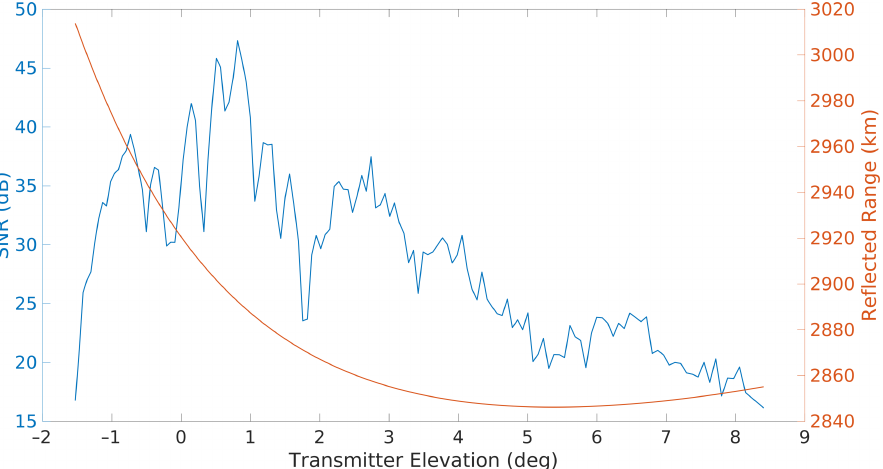
Figure 9. An example pass showing the detections of the International Space Station utilising a distant transmitter versus the elevation of the target. The blue line shows the detected signal to noise ratio and the red line shows the signal path length and the reflected range. The reflected range is given by ρ rx + ρ tx and does not include the baseline length to give the full bistatic range, as in Equation